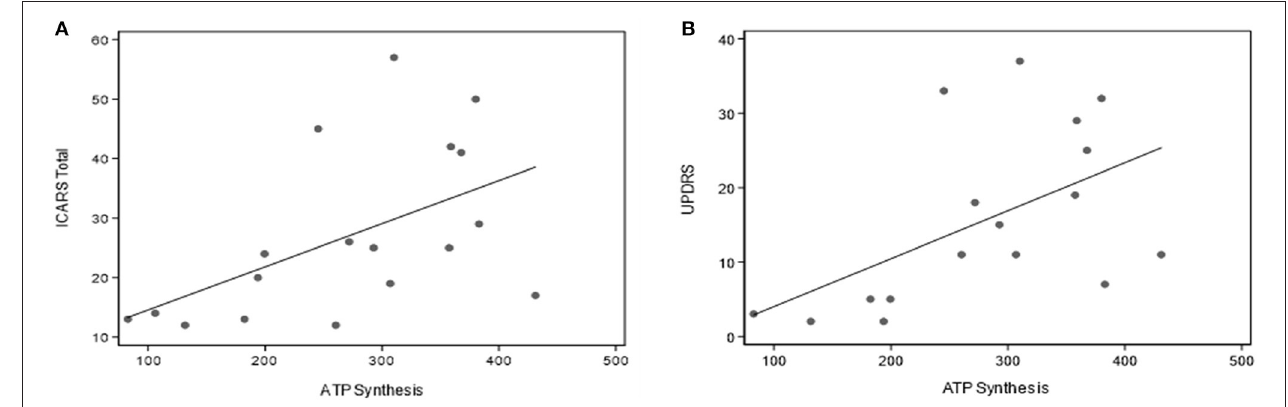
FIGURE 3 | Scatterplots representing the linear relationships between ATP synthesis and ICARS (A) and UPDRS (B) scores in the total sample of PM carriers.